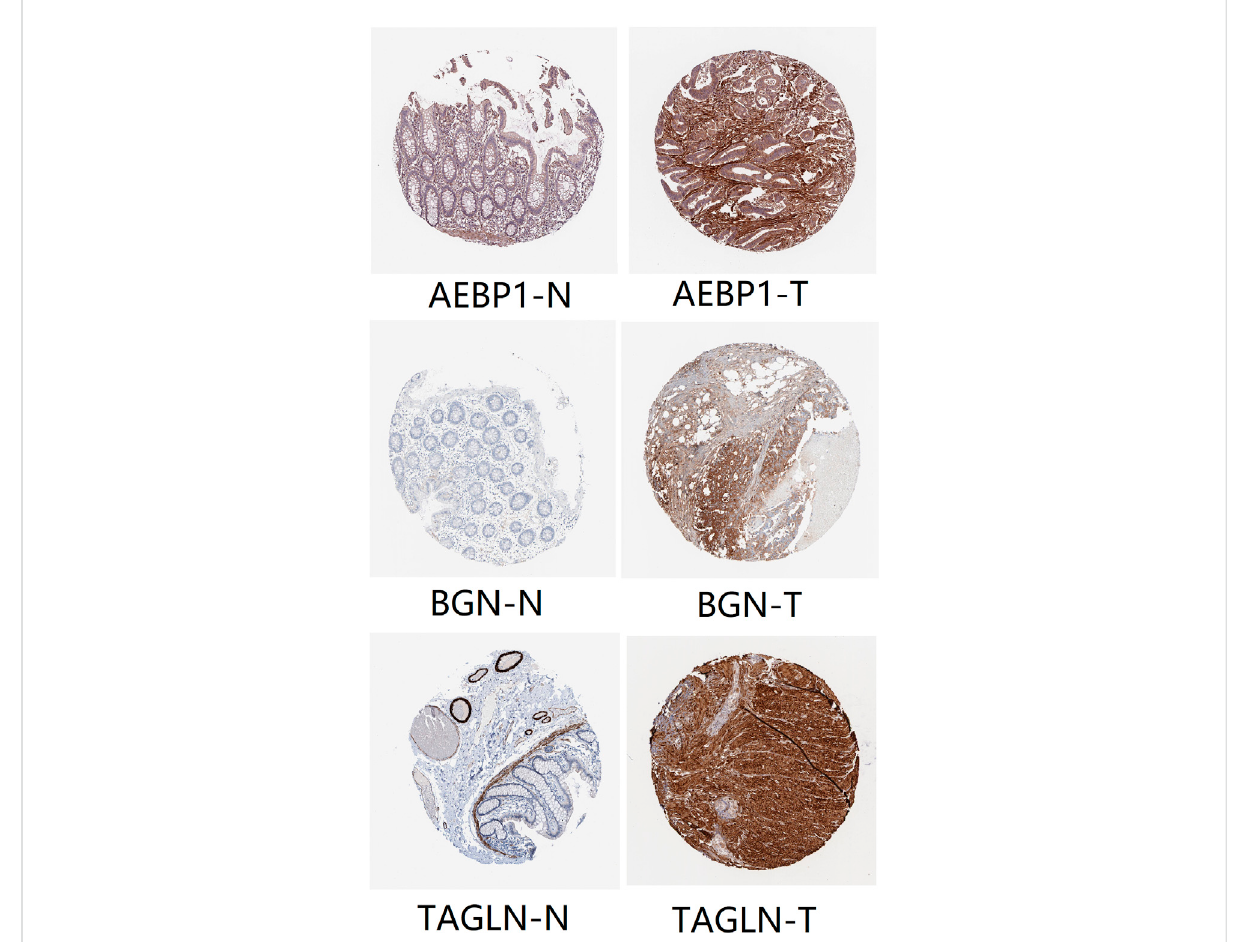
FIGURE 12 Protein expression levels of AEBP1, BGN, and TAGLN. “ T ” represents tumor, and “ N ” represents normal